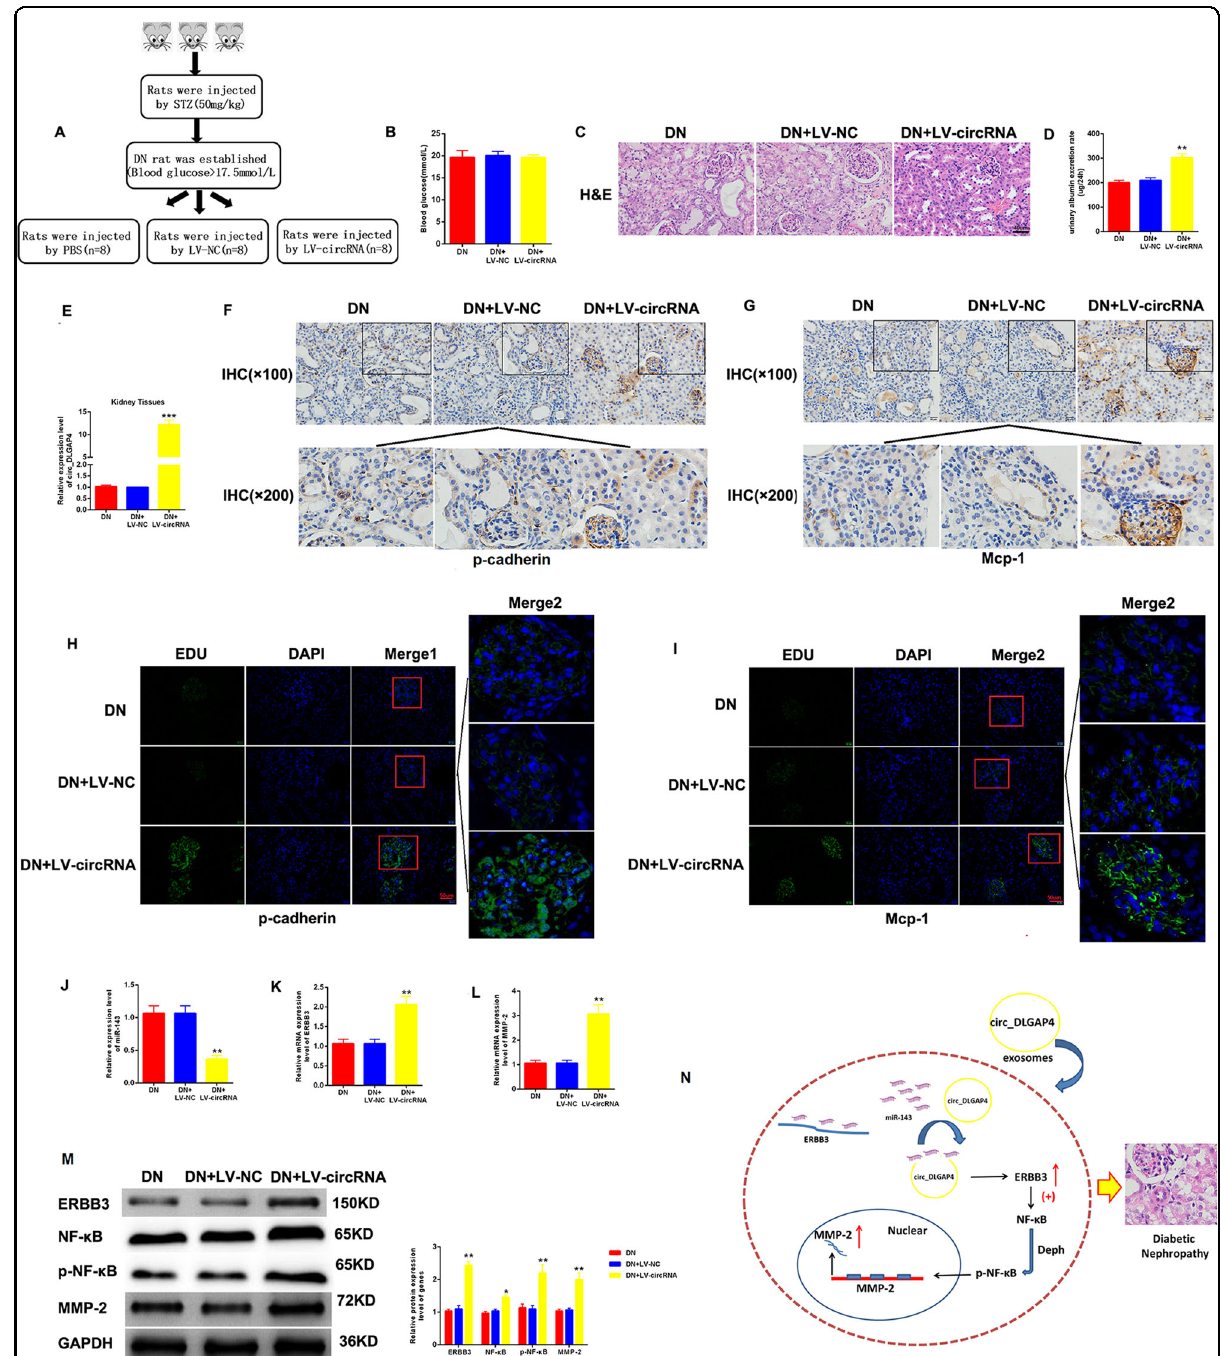
Fig. 7 Overexpression of circ_DLGAP4 promoted DKD progression in vivo. A Graphical representation of DKD model treated with PBS, LV-NC, or LV- circ_DLGAP4. B Blood glucose was detected in DKD + PBS group, DKD + LV-NC group, and DKD + LV-circ_DLGAP4 group. C HE staining results of the DKD + PBS group, DKD + LV-NC group, and DKD + LV-circ_DLGAP4 group. D Urinary albumin excretion rate was measured in the DKD PBS group, DKD + LV-NC group, and DKD + LV-circ_DLGAP4 group. E circ_DLGAP4 expression in kidney tissues from DKD + PBS group, DKD + LV-NC group, and DKD + LV-circ_DLGAP4 group. F , G The expression level of p-cadherin and Mcp-1 was measured by IHC in DKD + PBS group, DKD + LV-NC group, and DKD + LV-circ_DLGAP4 group. H , I The expression level of p-cadherin and Mcp-1 was assessed using IF assays in in DKD + PBS group, DKD + LV-NC group, and DKD + LV-circ_DLGAP4 group. J – L The expression level of miR-143, ERBB3, and MMP-2 mRNA were measured in DKD + PBS group, DKD + LV-NC group, and DKD + LV-circ_DLGAP4 group. M The protein expression levels of ERBB3/p-NF- κ B/MMP-2 axis was detected in DKD + PBS group, DKD + LV-NC group, and DKD + LV-circ_DLGAP4 group. N Schematic diagram of mechanism of circ_DLGAP4/miR-143/ERBB3/p-NF- κ B/MMP-2 in DKD progression was provided. Three independent experiments were conducted. Error bars stand for the mean±SD of at least triplicate experiments; ** P